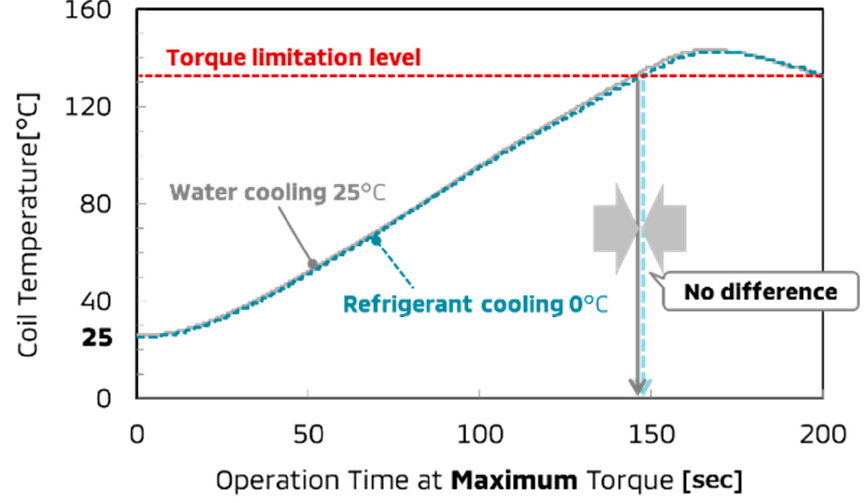
Figure 9. Coil temperature vs operation time at maximum torque.